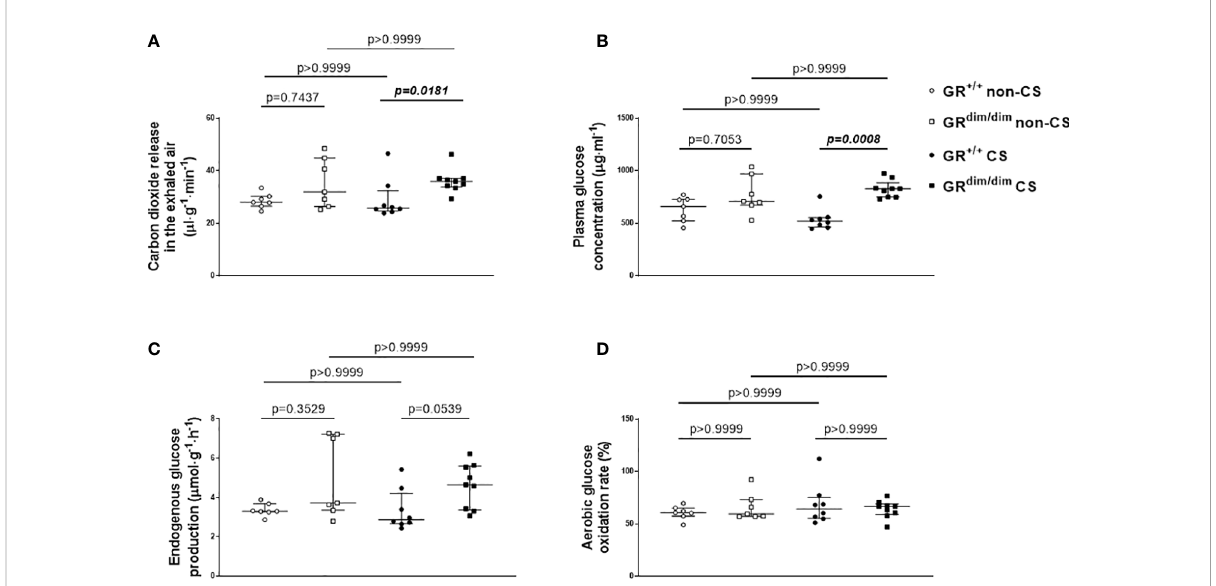
FIGURE 3 Glucose metabolism. (A) Carbon dioxide release via the exhaled air, (B) plasma glucose concentration, (C) endogenous glucose production rate, and (D) glucose oxidation as percentage of oxidation of infused tracer. GR +/+ mice non-CS: n=7, GR dim/dim mice non-CS: n = 7, GR +/+ mice CS: n = 8, GR dim/dim mice CS: n = 9. Data is presented as median (25 th and 75 th percentile and